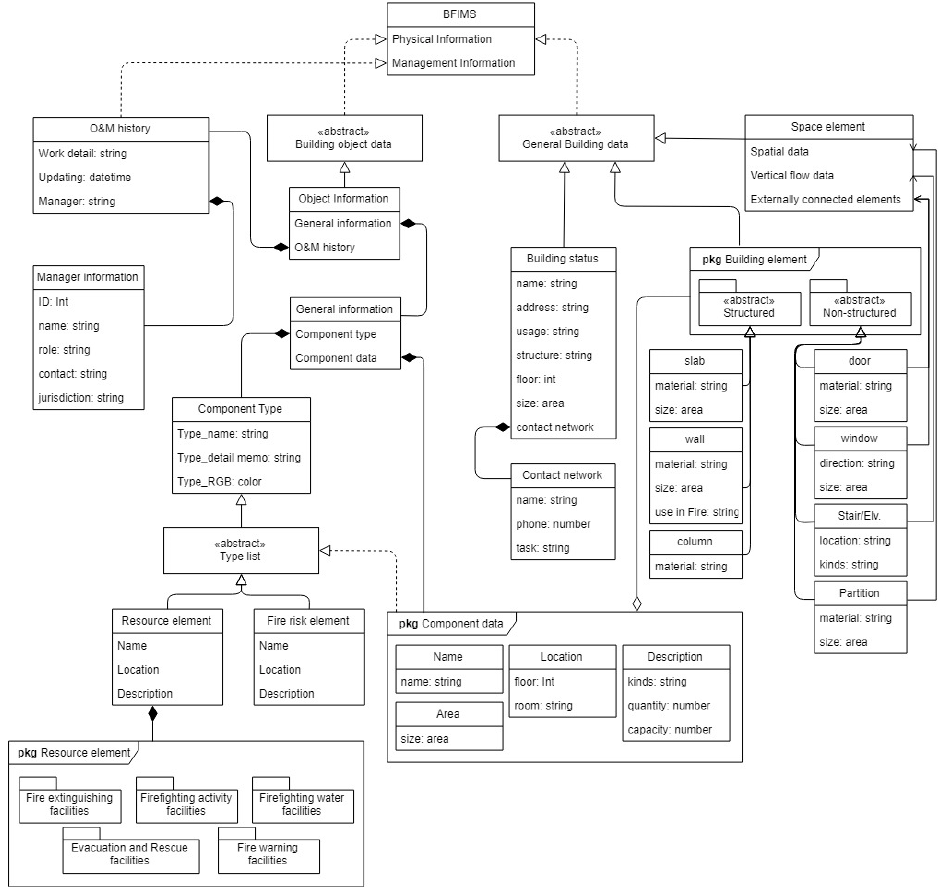
Figure 2. Unified Modeling Language (UML )diagram of conceptual data model for BFIMS .